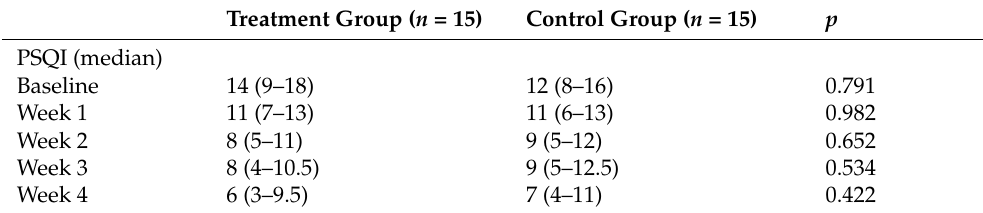
Table 3. Comparison of the PSQI scores between the treatment and control groups.